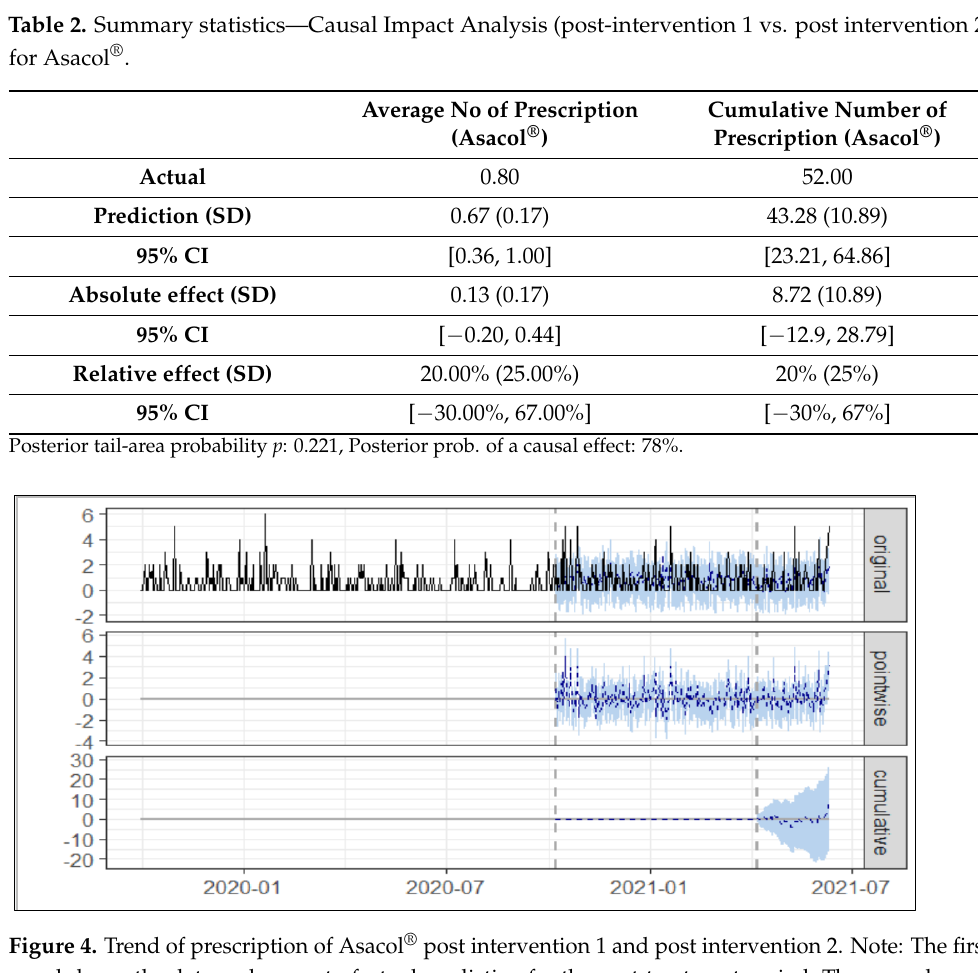
panel shows the data and a counterfactual prediction for the post-treatment period. The second panel panel shows the difference between observed data and counterfactual predictions. This is the